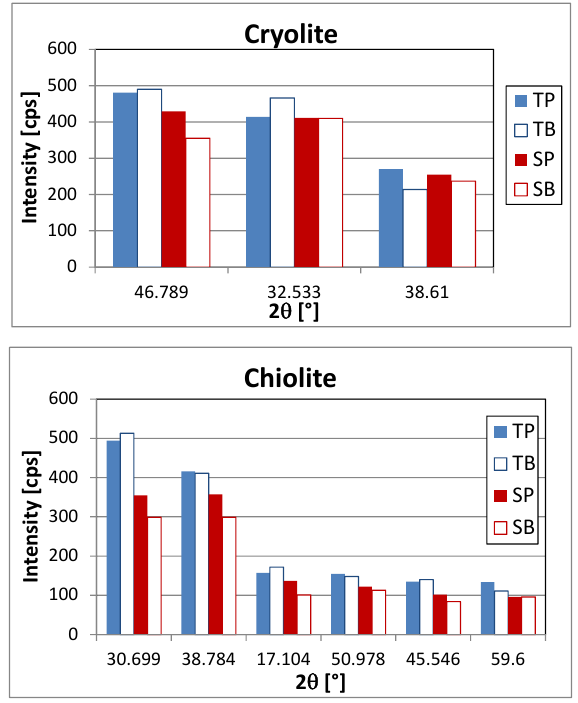
Figure 3. Distribution of the crystallized cryolite ( top ) and chiolite ( bottom ) in the frozen bath samples as revealed by XRD.